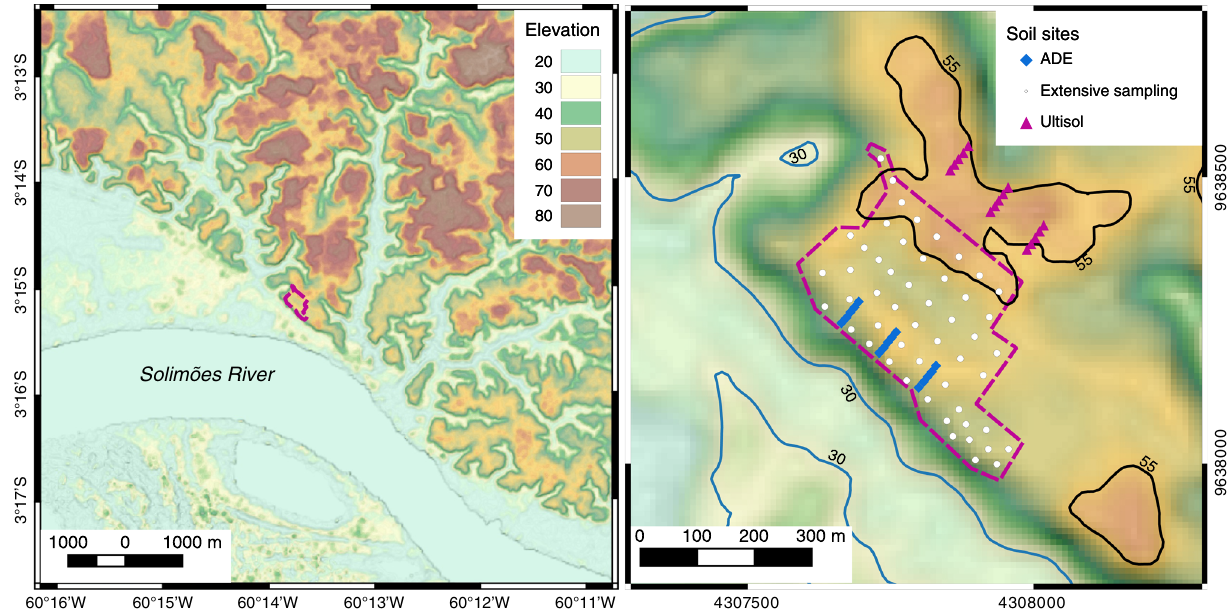
Fig. 7 Topographic position at the study site. Elevation from SRTM data shows the study site occurs on a common terrace (45 – 55m). The lower contour line occurs near areas of Entisols (Aquents or Fluvents) within the modern fl oodplain (below 30m) and the upper contour line occurs in areas of Ultisols (above 55m). The area between the fl oodplain and Ultisols contains the